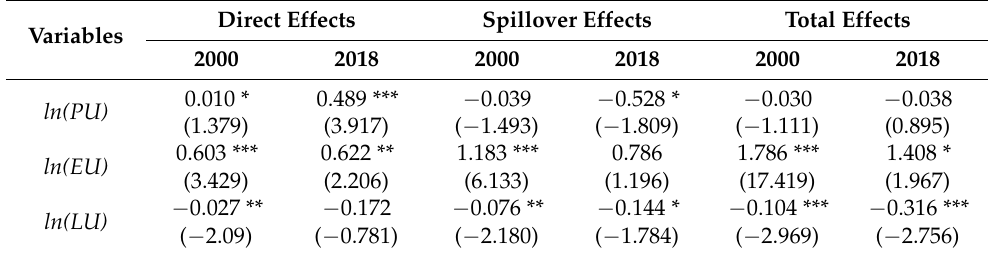
Table 3. P.D.E decomposition of the driving effect of multi-dimensional urbanization on carbon